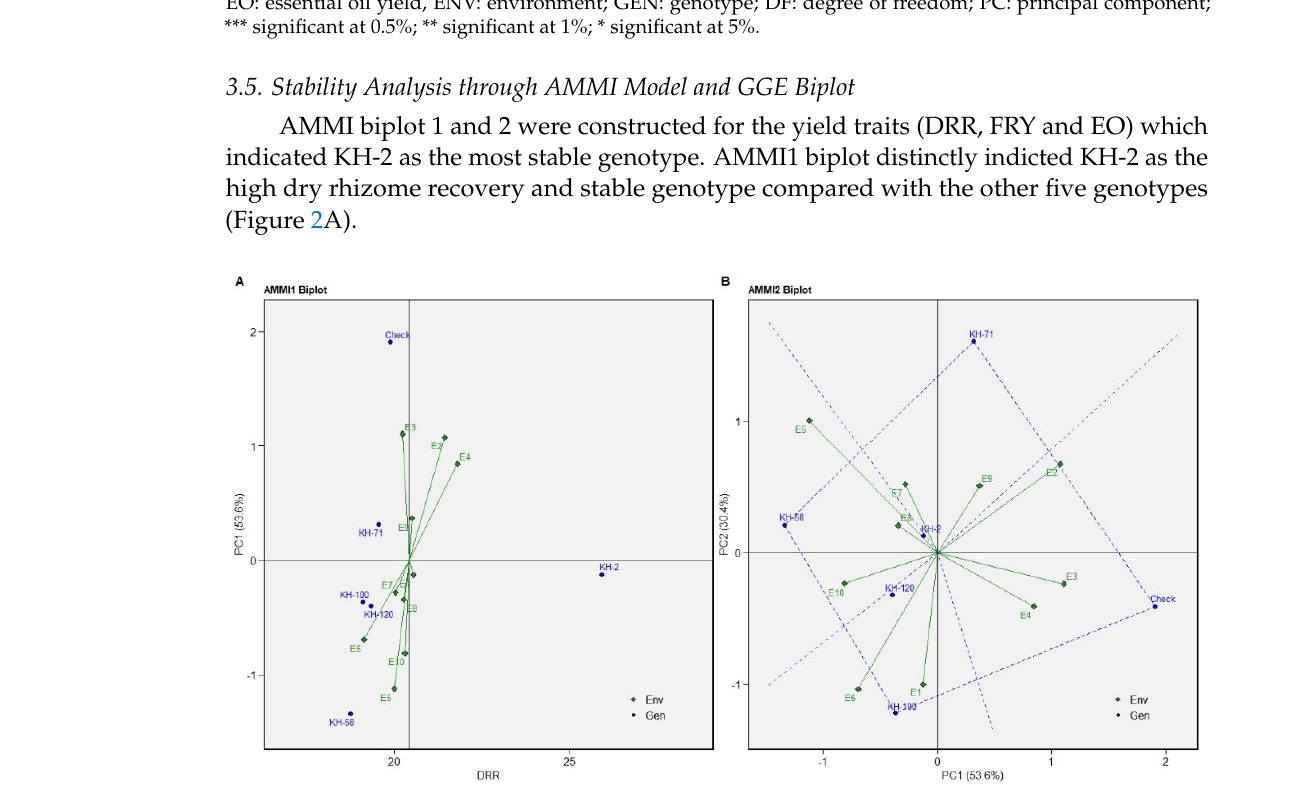
Figure 2. ( A ) AMMI1 biplot ( B ) AMMI2 biplot of DRR of five selected accessions and the check variety of C. caesia germplasm for eleven environments.